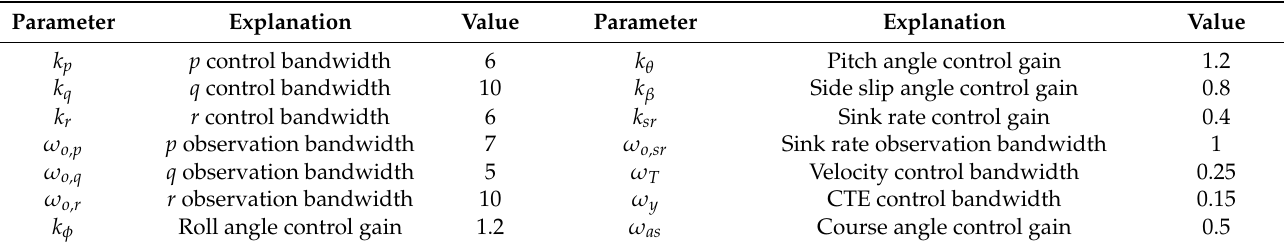
Table 4. Inner and outer loop control